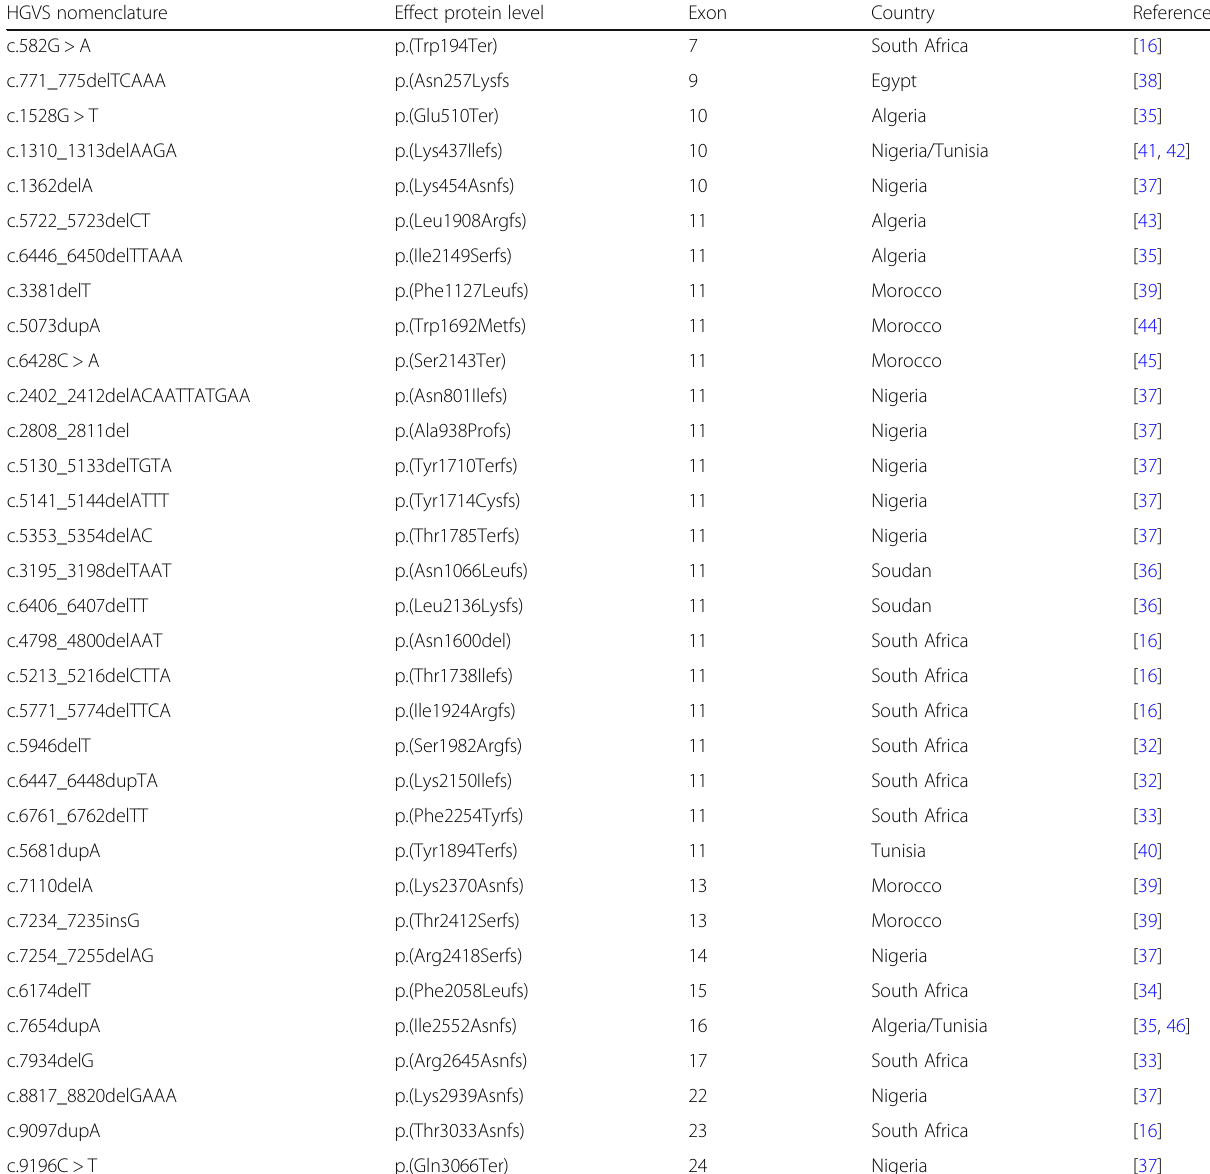
Table 2 BRCA2 associated pathogenic variants reported in African populations (RefSeq